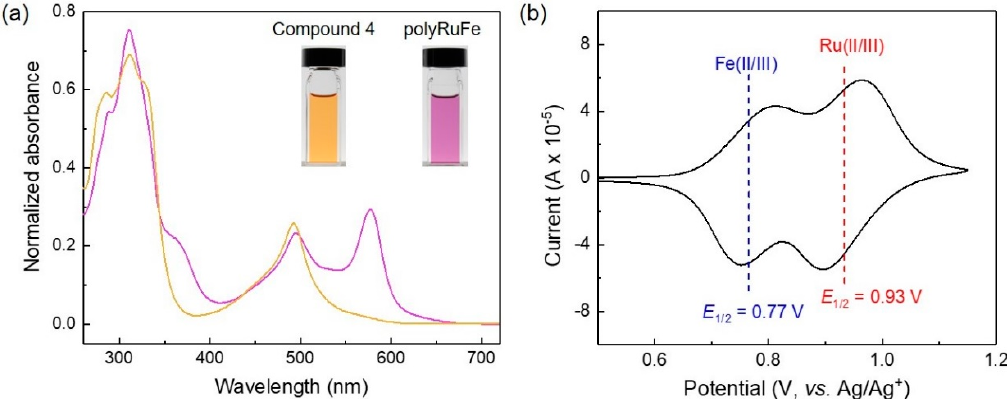
Figure 3. ( a ) UV–vis spectra of compound 4 (5 × 10 − 6 M in DCM/MeOH 1:1, v / v ) and polyRuFe (5 × 10 − 6 M in DMSO), with their color in solution (inset). ( b ) Cyclic voltammogram of polyRuFe in a three-electrode system (glassy carbon as a working electrode, platinum flag as a counter electrode, and Ag/Ag + as a reference electrode; electrolyte: 0.1 M LiClO 4 in CH 3 CN, scan rate 50 mV/s).